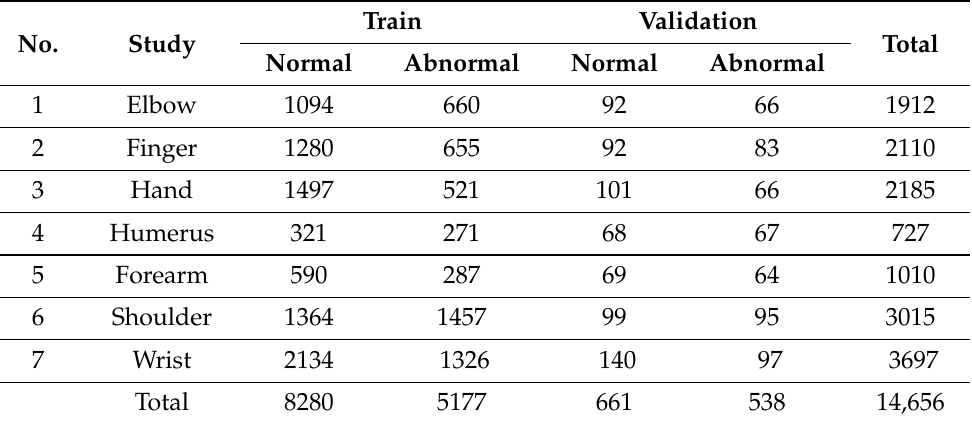
Table 1. Distribution of studies of the Stanford MURA (musculoskeletal radiographs) data set [59] for studies of the upper body.